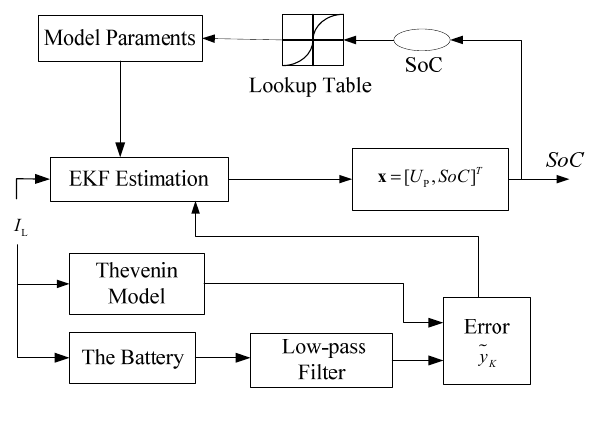
Figure 7. The SoC estimation flow based on